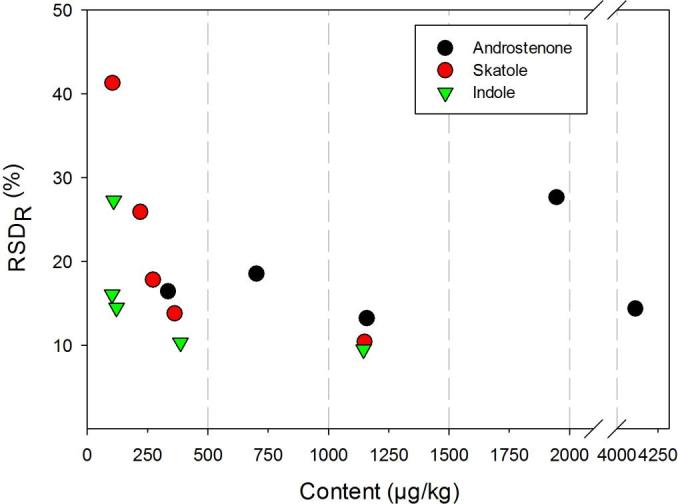
Dependence of reproducibility relative standard deviation (RSDR) on analyte content.